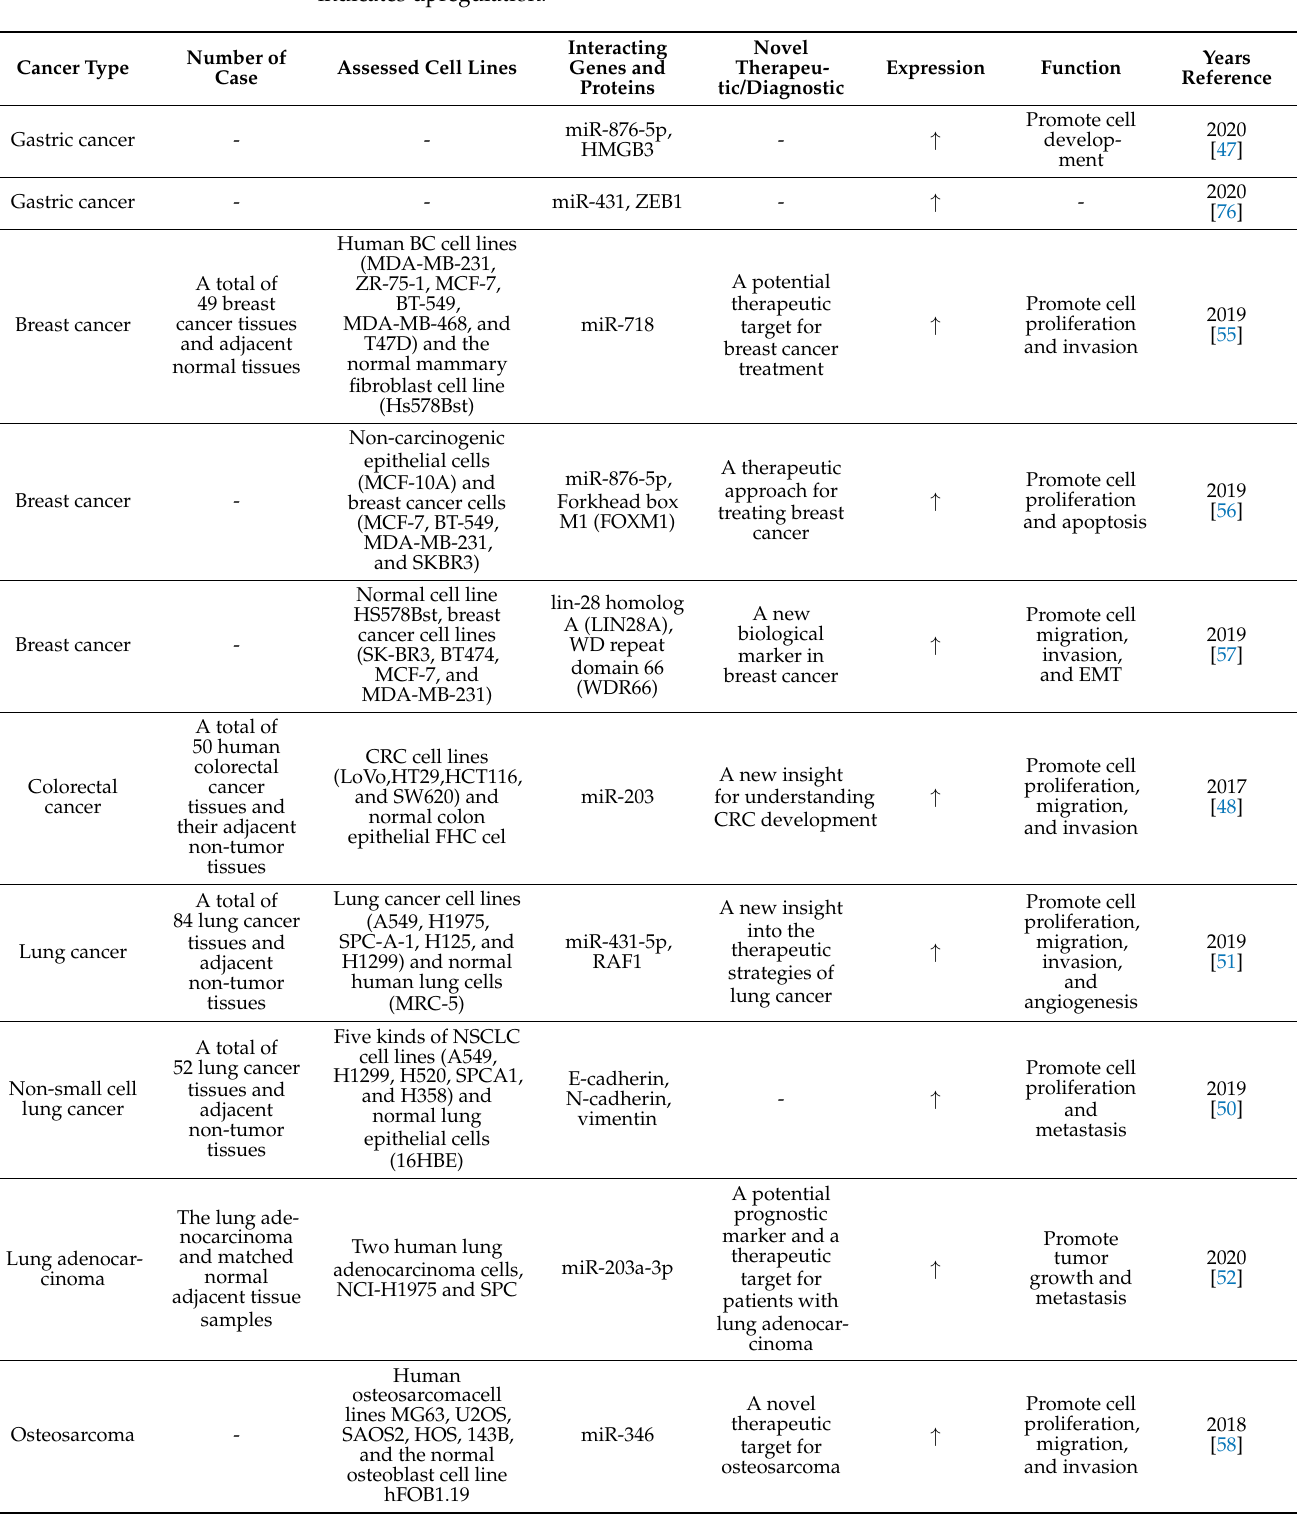
Table 4. Functional characterizations of FBXL19-AS1 in multiple human cancers. ↑ in the table indicates